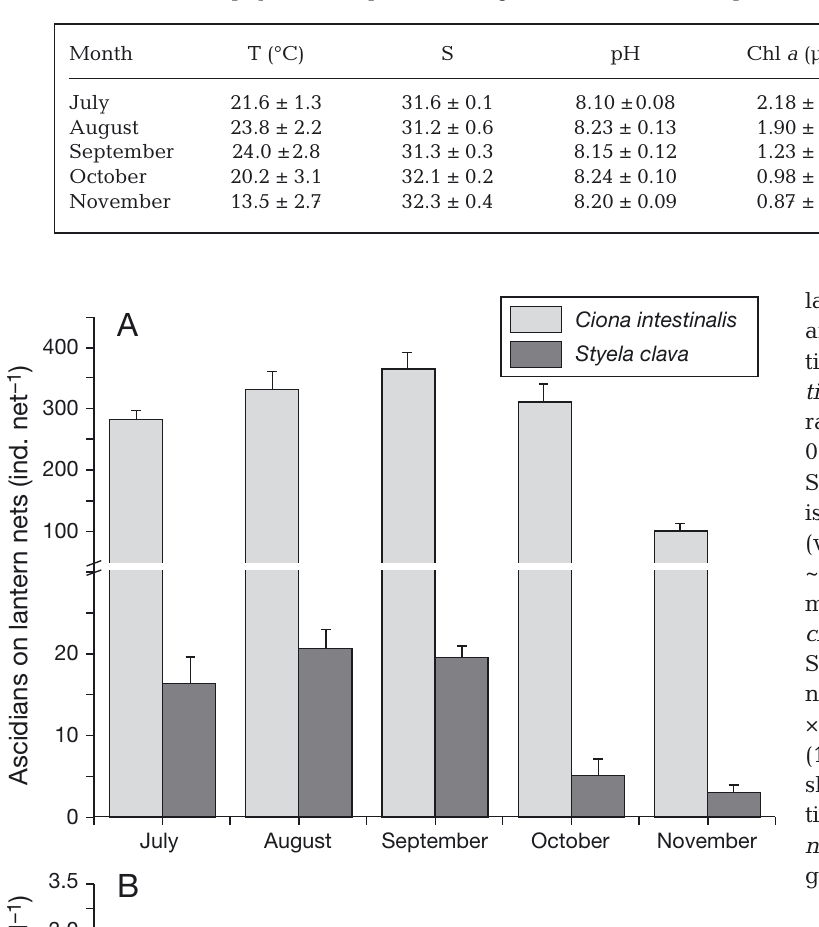
Table 1. Water column characteristics at the study site in Sanggou Bay, northern China. T: temperature; S: salinity; Chl a : chlorophyll a ; POM: particulate organic matter; TPM: total particulate matter. Values are means ± SE